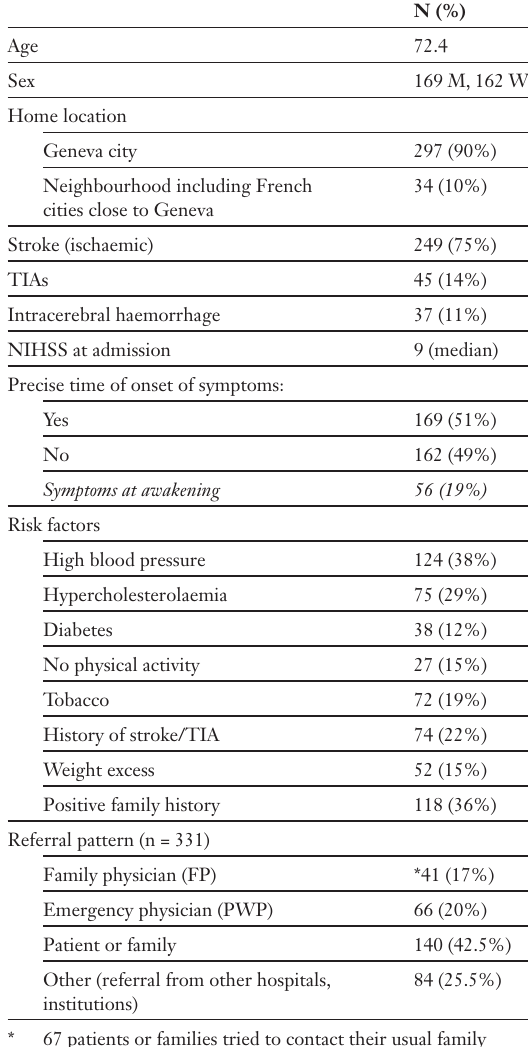
Baseline characteristics of the study population (n = 331).